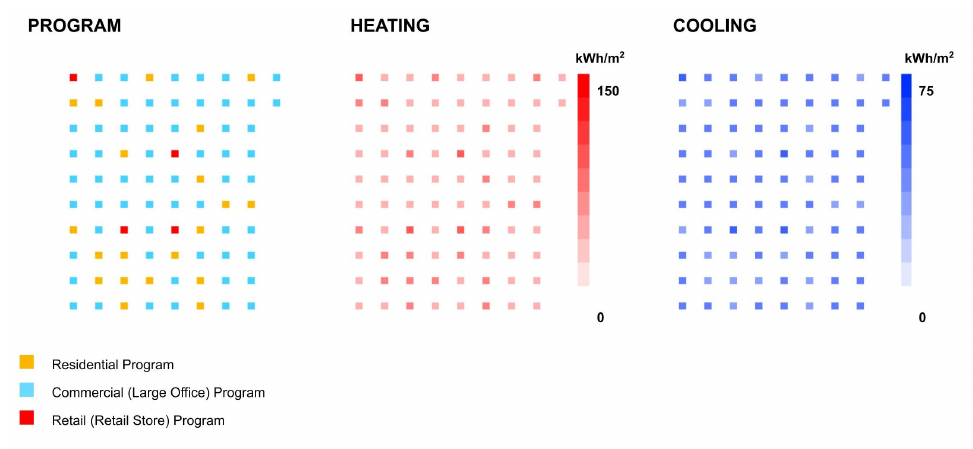
Figure 10. Simulation results from the program design phase.